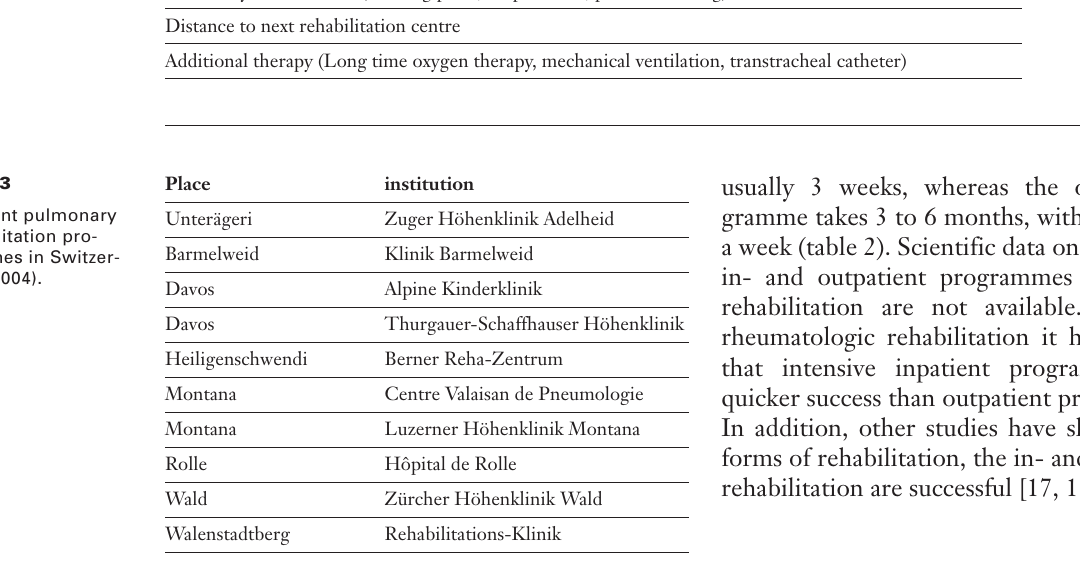
Criteria for in- and outpatient pulmonary rehabilitation.